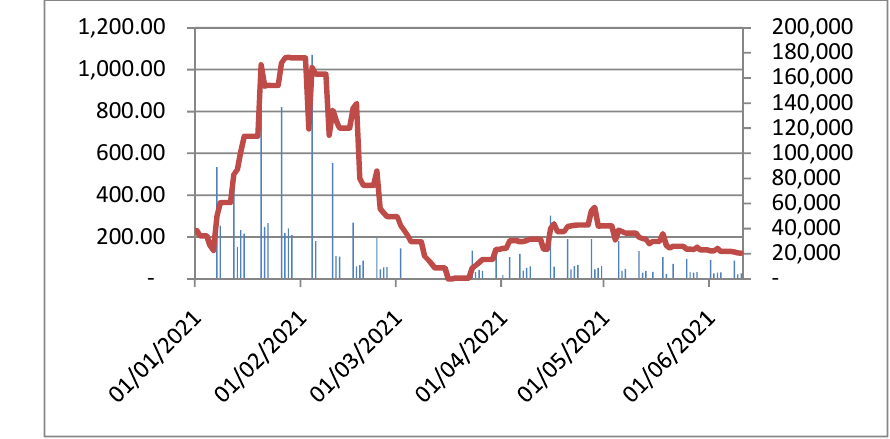
Figure 5 – Spain in the period Jan1-August 11, 2021. The blue bars are the daily numbers of infected people. The red line is the ECDC index. Note that the Spanish Ministry of Health report four days of cases, followed by the next 3 days without